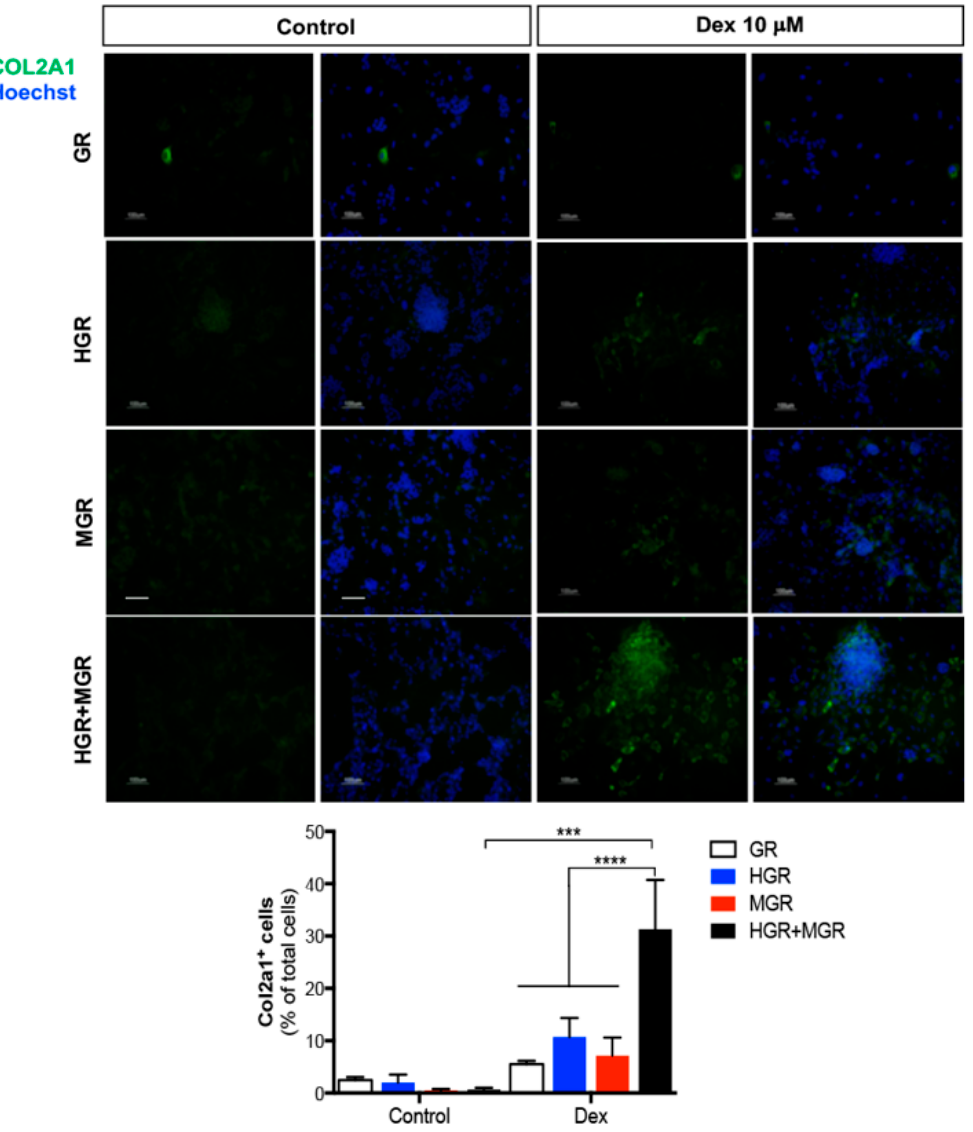
Figure 9. Activation of HGR and MGR nuclear translocation in double transgenic cells increases the number of differentiated COL2A1-positive cells. Cells were differentiated under control conditions or with 10 µ M Dex for 10 days and immuno-stained with anti-COL2A1 antibody ( A ). ( B ) Quantification of the number of COL2A1 + cells. Double-transgenic cells produced a higher proportion of chondrocytes compared with stimulated GR, MGR, or HGR cells as well as unstimulated double transgenic cells. The mean ± SEM from 3 independent experiments is presented. Statistical analysis of all conditions was conducted with ANOVA followed by Tukey’s multiple comparison test and only the significant differences are indicated in the graph. The scale bars represent 100 µ m *** p < 0.001, and **** p < 0.0001.